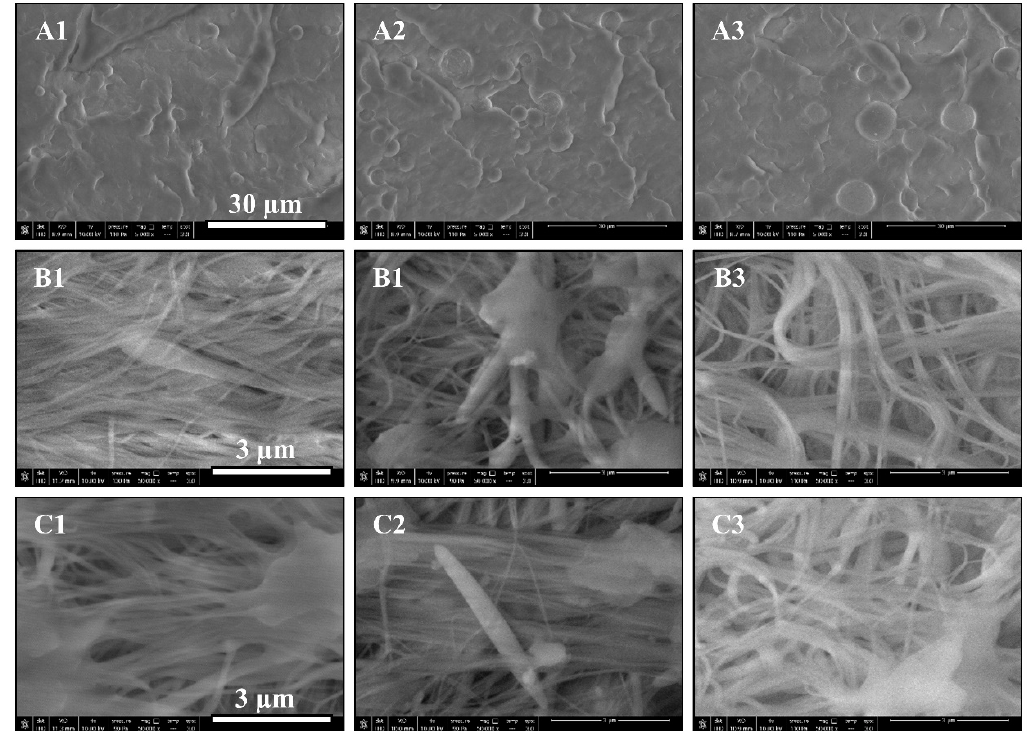
Figure 3. SEM images of the spherical and fibrillar PET dispersed in polypropylene (PP) matrix. 1, 2, and 3 denote PET concentrations of 3, 7, and 15 wt.%, respectively. ( A – C ) denote prespunbond, postspunbond, and post-MNL (micro- / nanolayer) processing stages, respectively.